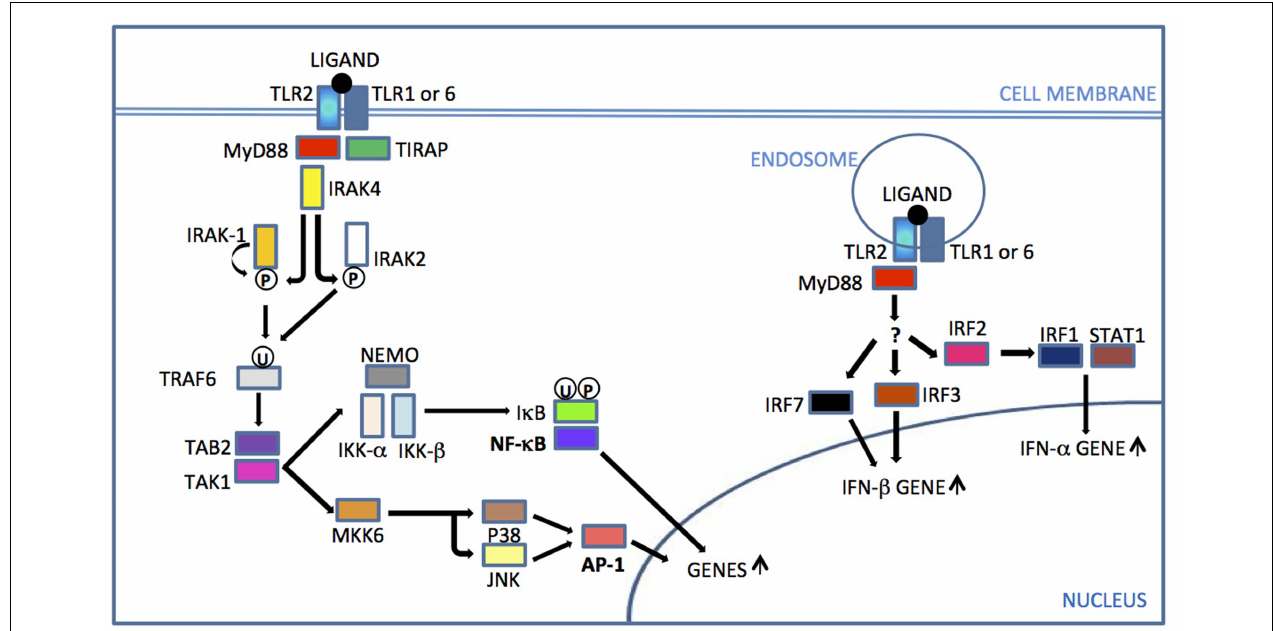
FIGURE 1 |TLR2 signaling. After ligand recognition and consequentTLR2 dimer rearrangement, theTIR domain ofTIRAP binds theTIR domain ofTLR2 and recruits the adaptor protein MyD88. IRAKs are then recruited and IRAK 4 phosphorylates (P) IRAK1, which then initiates auto-phosphorylation. Phosphorylated IRAK1 dissociates from the complex and activatesTRAF6. Since IRAK1 is rapidly degraded, IRAK2 also activatesTRAF 6 in latter responses. Ubiquitinated (U)TRAF6 triggers the activation sequence TAB2 –TAK1 – IKK complex. I κ B phosphorylation and ubiquitination by the